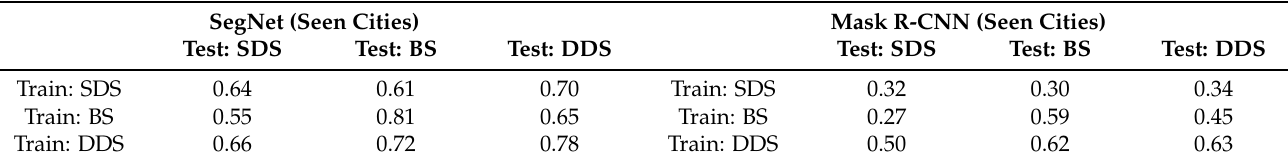
Table 8. Robustness to different building density (RQ6). Test set DICE scores of SegNet and Mask R- CNN trained on areas with sparse detached structure (SDS), block structure (BS), and dense detached structure (DDS), respectively. The test data contain cities already seen during training.